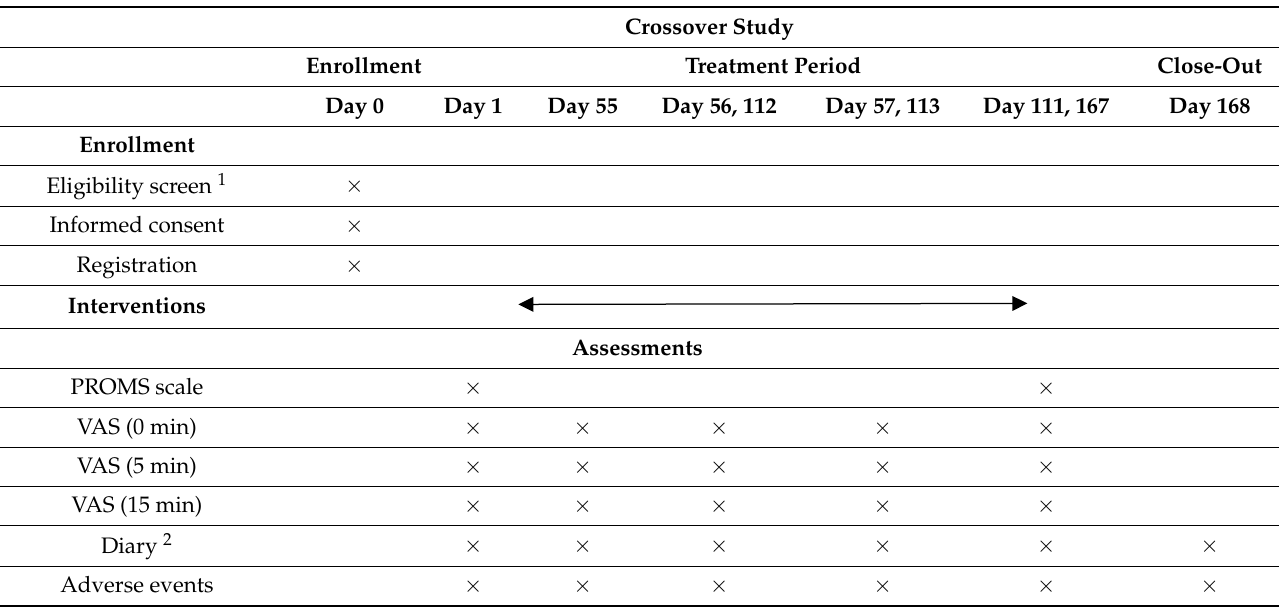
Table 5. Summary of the study assessments and procedures in the long-term extension study.